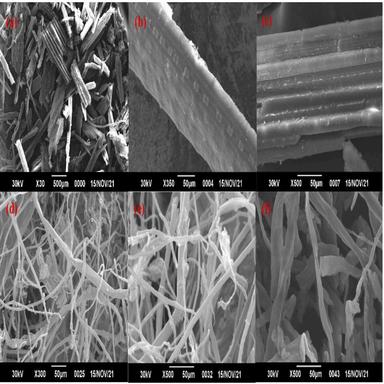
SEM images of MMB (a–c), MMC (d, e) and CC (f) at different magnitudes.